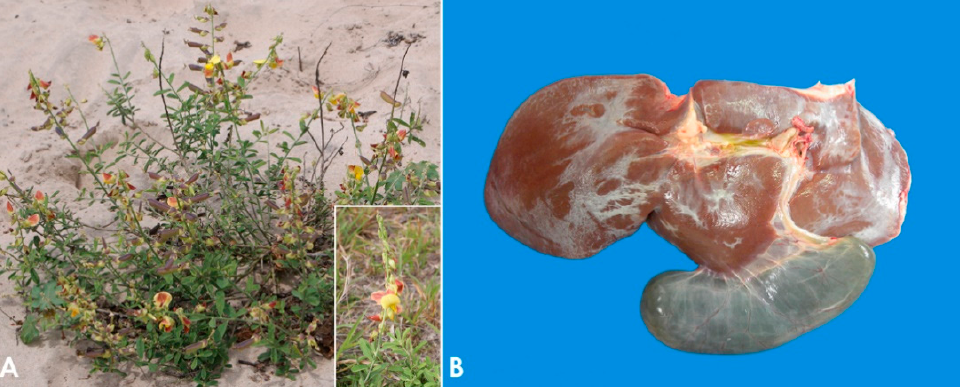
Figure 1. Pyrrolizidin alkaloid poisoning. ( A ) Crotalaria retusa plant. Inset: Detail of the flower. ( B ) Liver, sheep. Seneciosis. Moderately shrunken liver, with multifocally thickened Glisson’s capsule and distended gall bladder (Photo courtesy of Dr. Paula Giaretta).